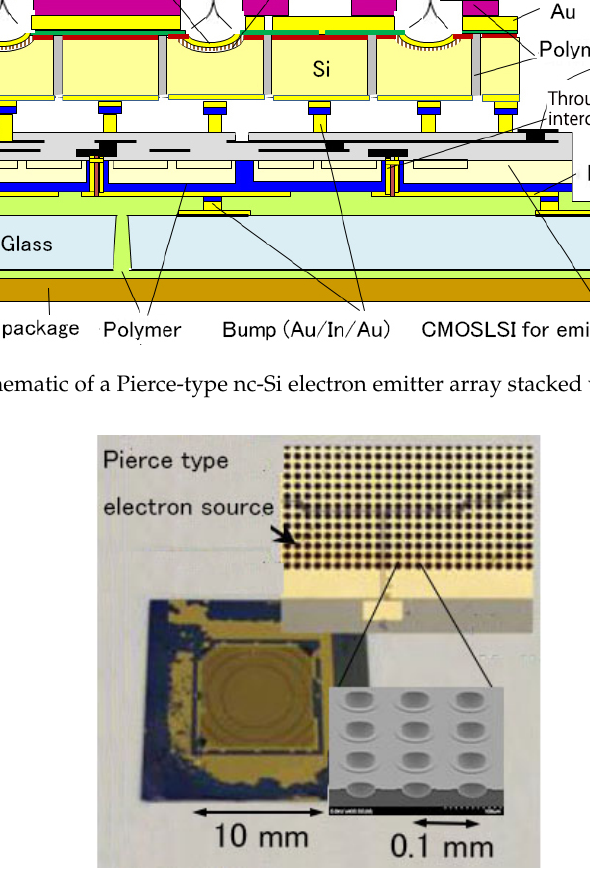
Figure 18. Photographs of Pierce-type nc-Si electron emitter array.